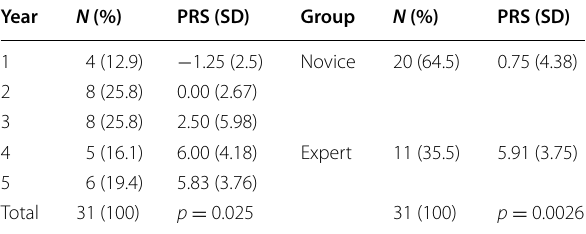
Table 1 Distribution of study subjects by residency year and mean performance rating scores